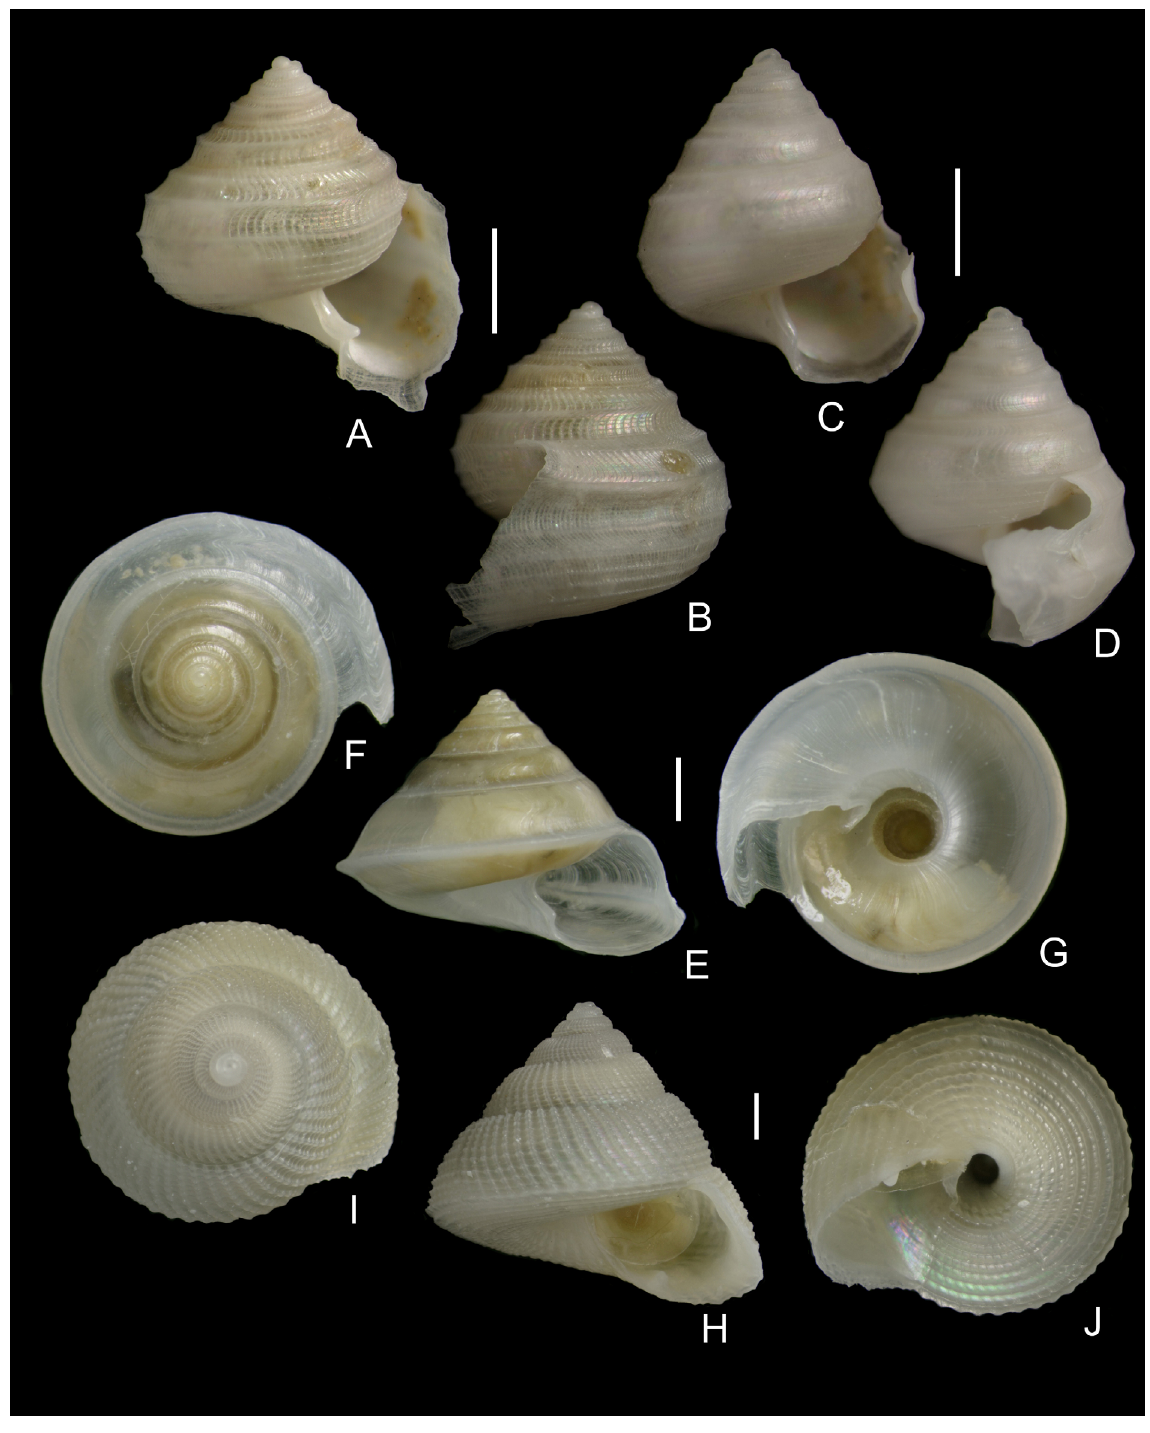
Fig. 12. Seguenziidae. A–B . Seguenzia elegans Jeffreys, 1885, BANGAL 0711, V10, 1720 m, height 3.4 mm. C–D . Seguenzia formosa Jeffreys, 1876, BANGAL 0711, V10, height 3.1 mm. E–G . Carenzia carinata (Jeffreys, 1877), BANGAL 0711, V10, height 4.2 mm. H–J . Ancistrobasis reticulata (Philippi, 1844), BANGAL 0711, V6, 909 m, height 6.5 mm. Scale bars = 1